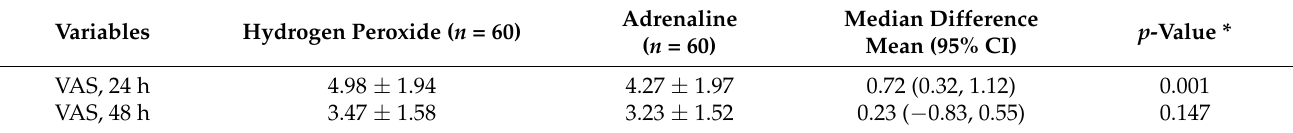
Table 2. Between-group comparison of postoperative pain